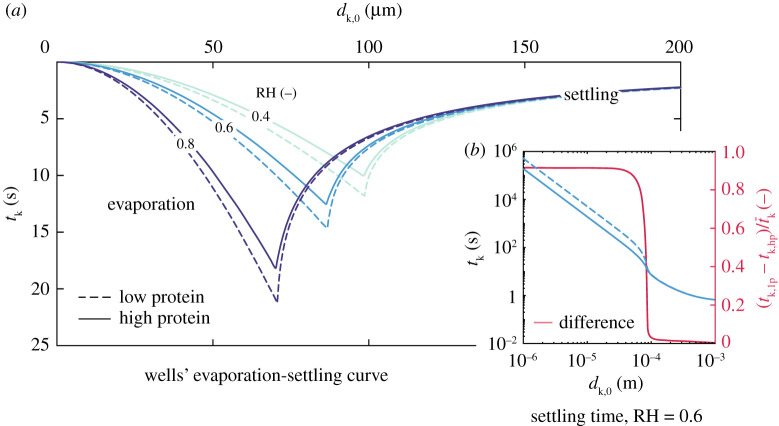
The (a) Wells’ evaporation-settling curve showing the time for either full droplet evaporation to its equilibrium size or its settling time to the ground for T = 20°C, RH = 40, 60 and 80%, and two saliva compositions: low protein sputum (9 mg ml−1 NaCl, 3 mg ml−1 protein) and high protein sputum (9 mg ml−1 NaCl, 76 mg ml−1 protein). In (b), the settling times for each composition (left axis) and their respective relative differences (right axis) are given for RH = 60%. Significant effect of composition on settling time scales depends on relative humidity, and is observed in droplets up to 100 μm, approximately. (Online version in colour.)